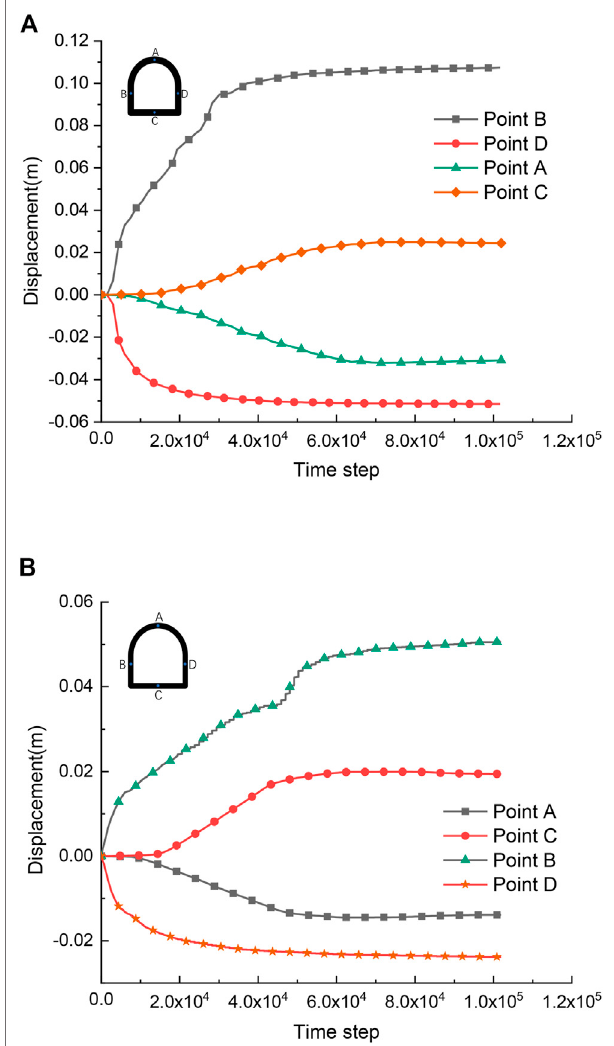
FIGURE13| Displacementofmonitoringpoints. (A) Case 1. (B) Case